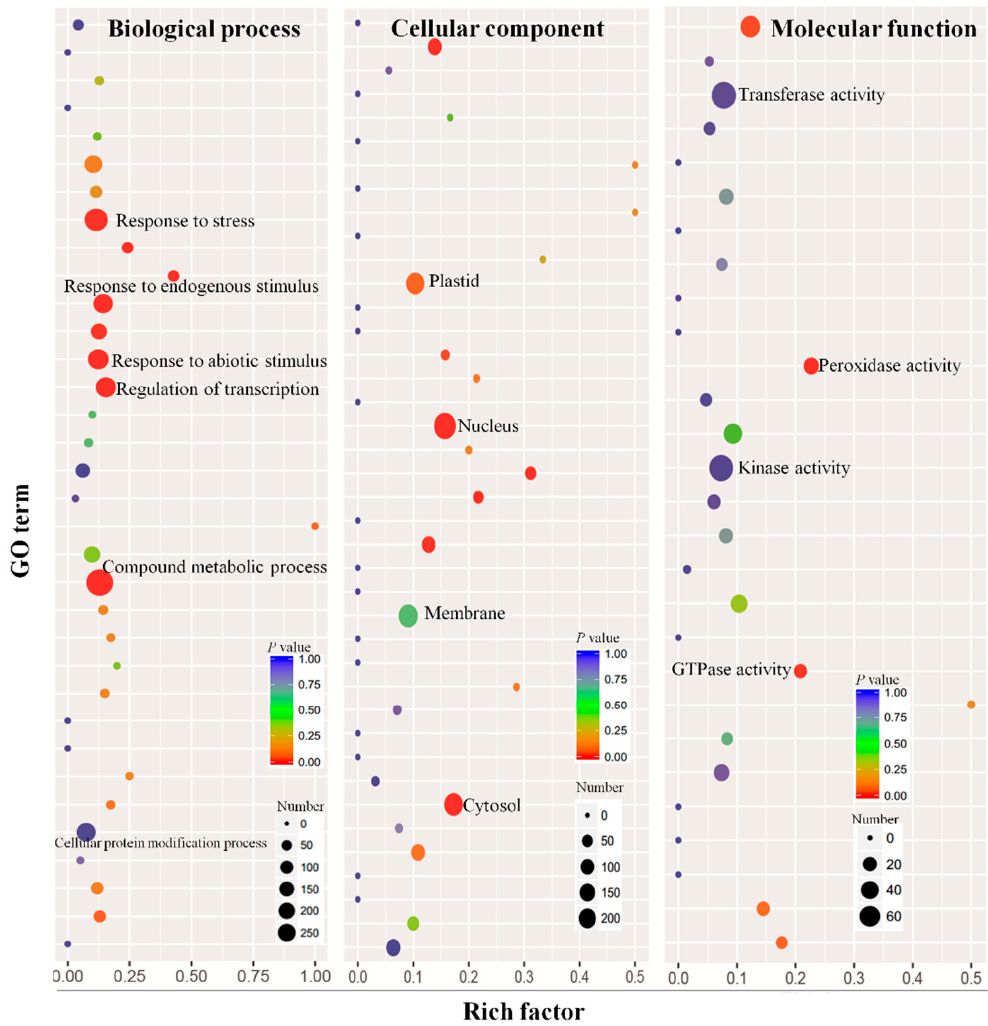
Figure 4. GO functional classification of identified target genes.